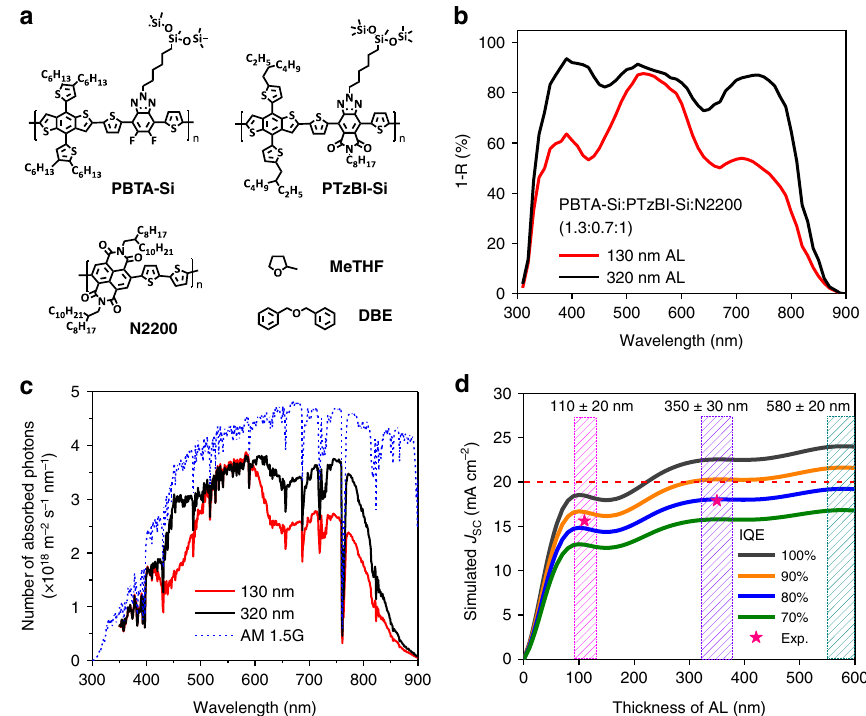
Fig. 1 Absorption pro fi les and optical simulations. a Chemical structure of active layer components and solvents. b Absorption pro fi les for PBTA-Si:PTzBI- Si:N2200 (1.3:0.7:1) blend fi lms with different active layer thickness, determined by re fl ection (double-pass) mode. c Number of absorbed photons versus wavelength for 1.3:0.7:1-cells with active layer thickness of 130 nm and 320 nm, simulated by transfer matrix formalism. d Simulated J SC versus active layer thickness based on constant IQE, with the red stars represent J SC calculated from experimental IQE; the dashed line and patterned areas are guides to the eyes